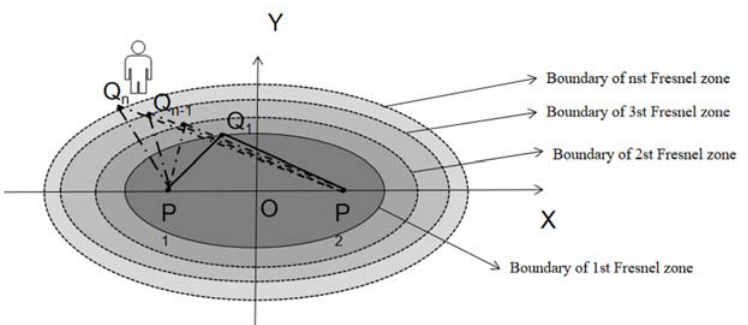
Figure 11. Fresnel zone model.